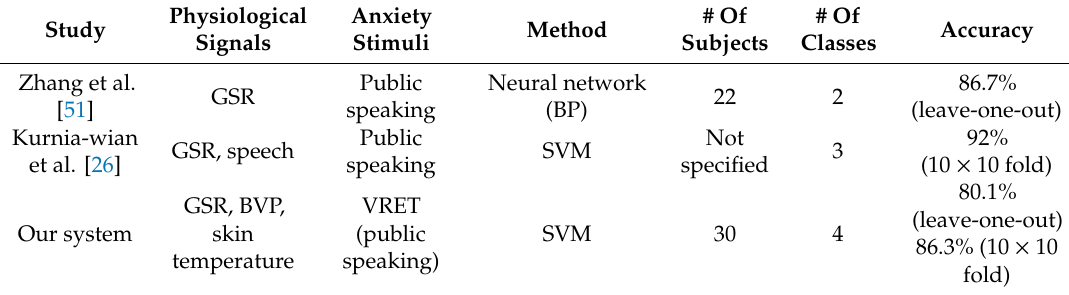
Table 6. Comparison with public speaking-induced stress recognition